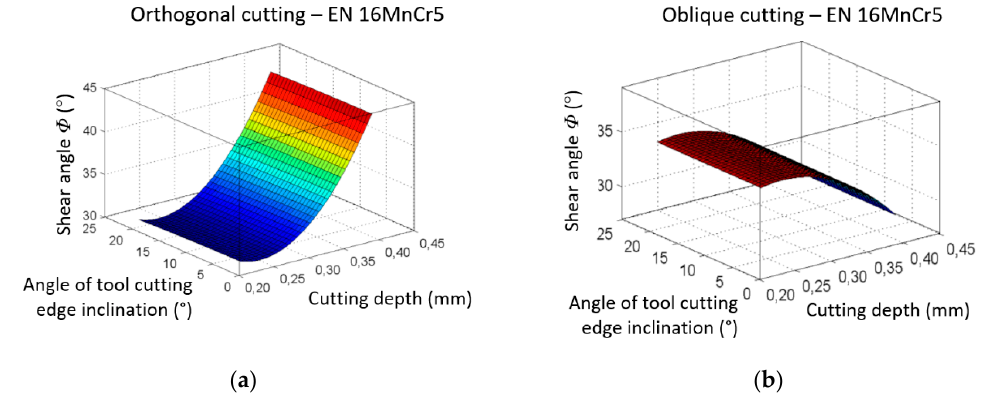
Figure 24. The dependence of shear angle Φ on cutting depth a p and angle of tool cutting edge inclination λ s ; ( a ) orthogonal cutting; ( b ) oblique cutting.